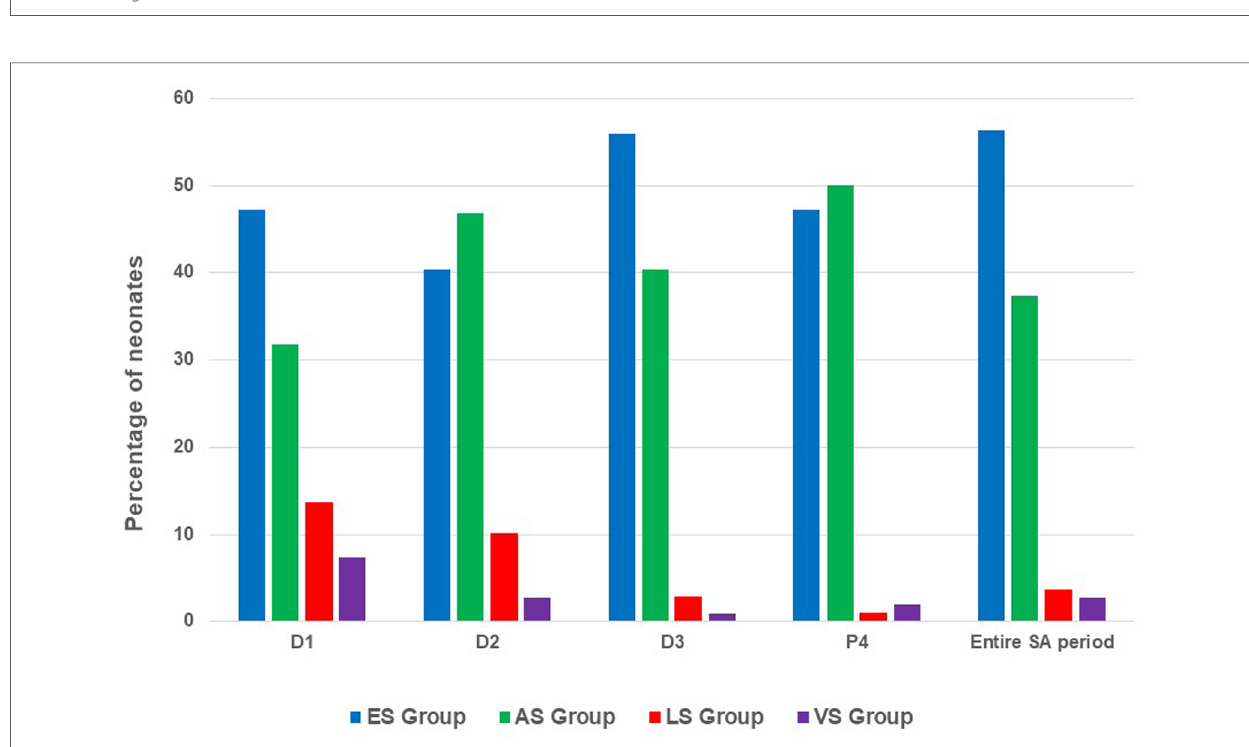
FIGURE 2 COMFORT-Behavior Scale score every day of therapeutic hypothermia. Data are median, interquartile range and minimum and maximum values. SA, sedation analgesia.